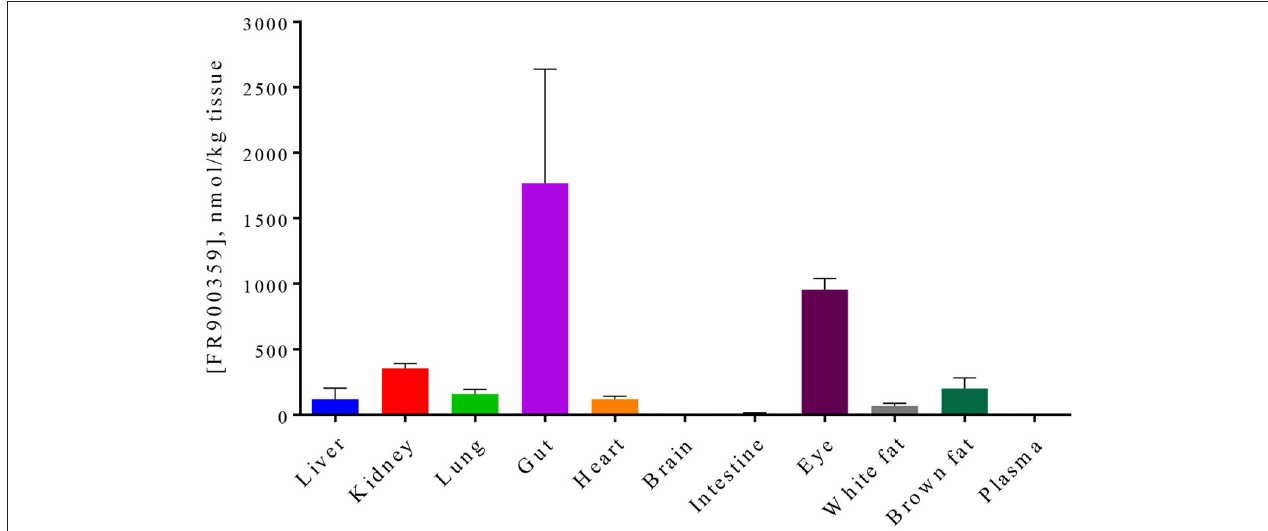
FIGURE 4 | Concentration of FR900359 ± SEM in various tissues after oral application of 0.2mg FR900359 in mice. Animals were sacrificed after ∼ 1.25h and organs as well as plasma were harvested and snap-frozen. FR900359 levels in organs from three mice were determined.